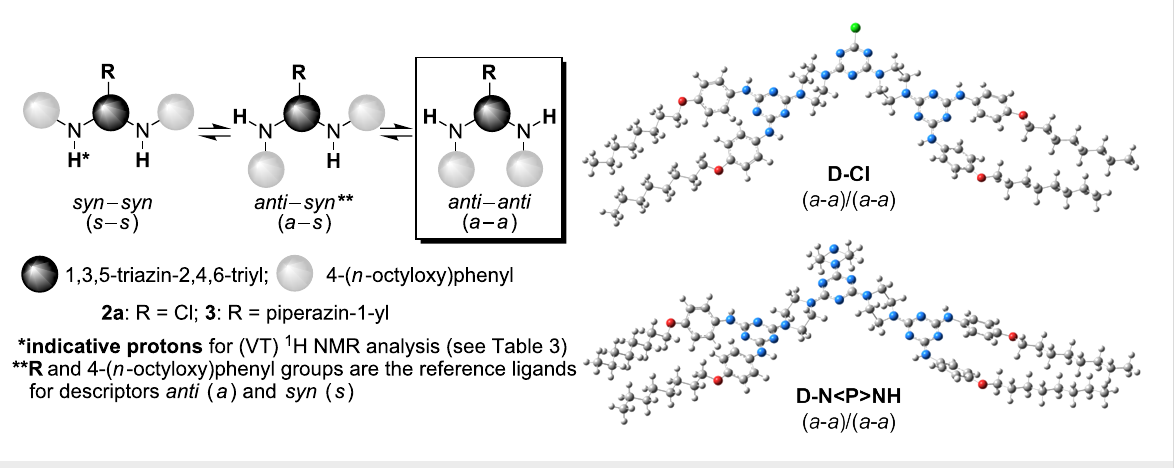
Figure 2: The three terms rotamerism of G-0 dendrons 2a and 3 about the C( s -triazine)–N(exocyclic) partial double bonds.